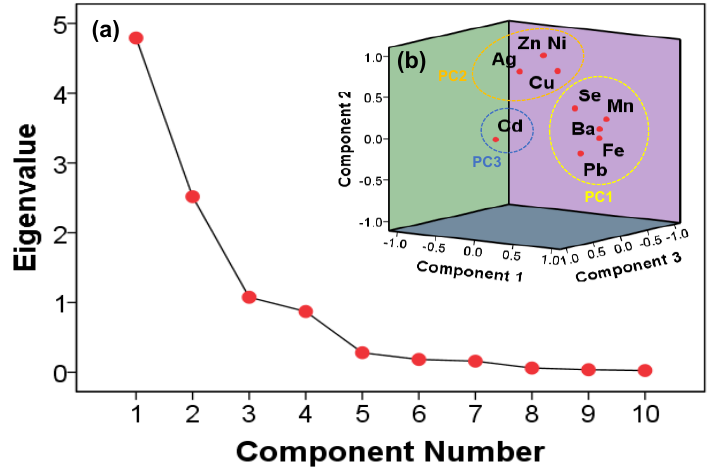
Figure 3. Principal component analysis (PCA) of 10 trace elements by ( a ) scree plot of the characteristic roots (eigenvalue) and ( b ) component plot in rotated space.